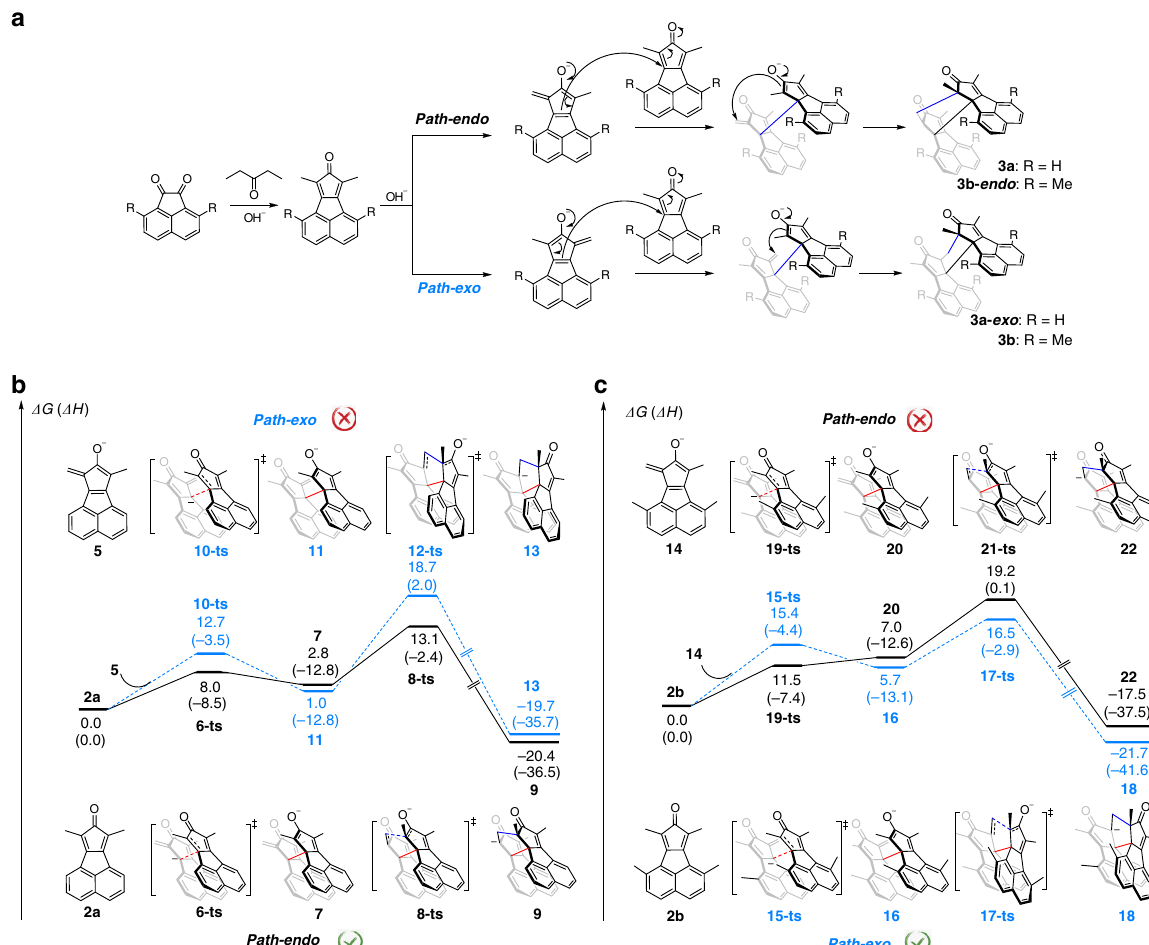
Fig. 3 Proposed mechanism. a Proposed mechanism of the nucleophilic addition cascade process. Free energy pro fi les of Path-endo (black) and Path-exo (blue) for the dimerization of b reactant 2a and c reactant 2b . Values (in kcal·mol − 1 ) represent the relative free energies calculated by the ω B97X-D//M11 method in methanol. The values in parentheses are the relative